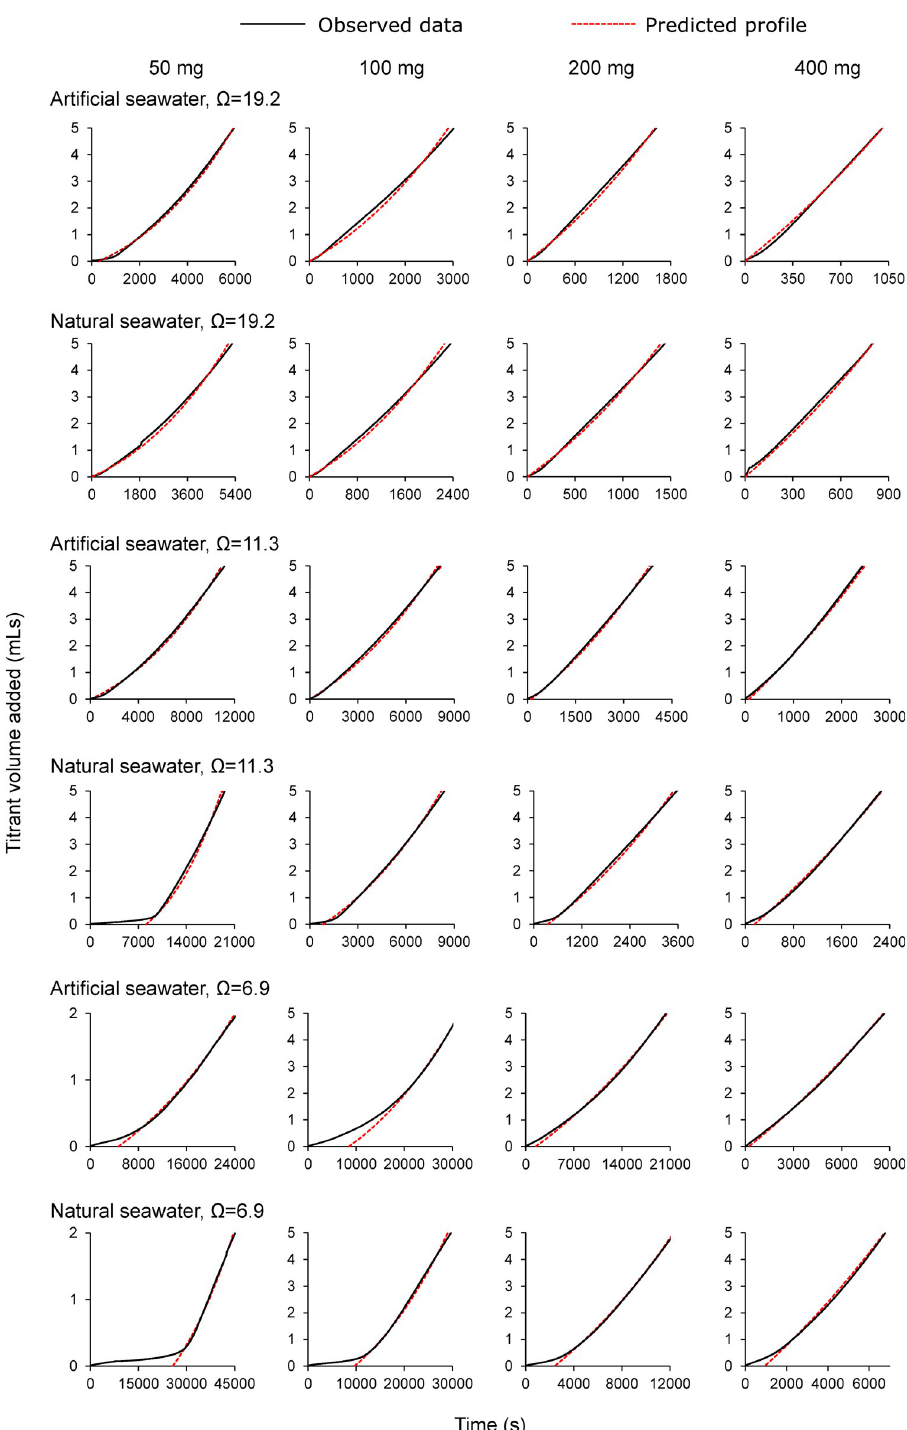
Fig 4. Titration profiles in seeded experiments with no added aspartic acid. Black lines show observed profile and red dotted lines show predicted profile as explained in text. N.B. the x- and y-axes are not to the same scale for all the